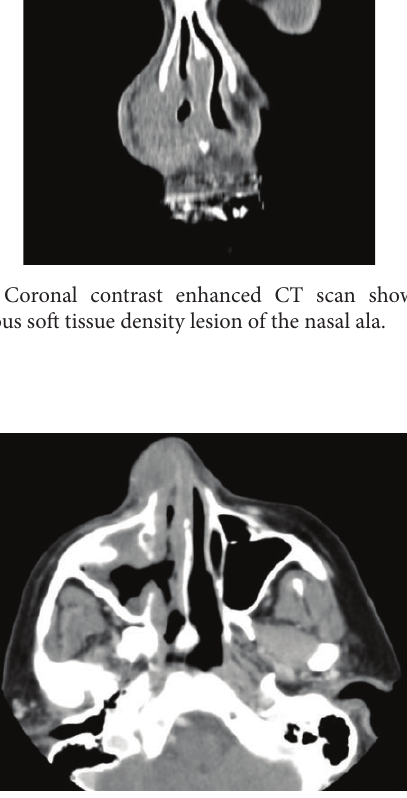
Figure 2: Axial contrast enhanced CT scan redemonstrating subcu- taneous nasal lesion.